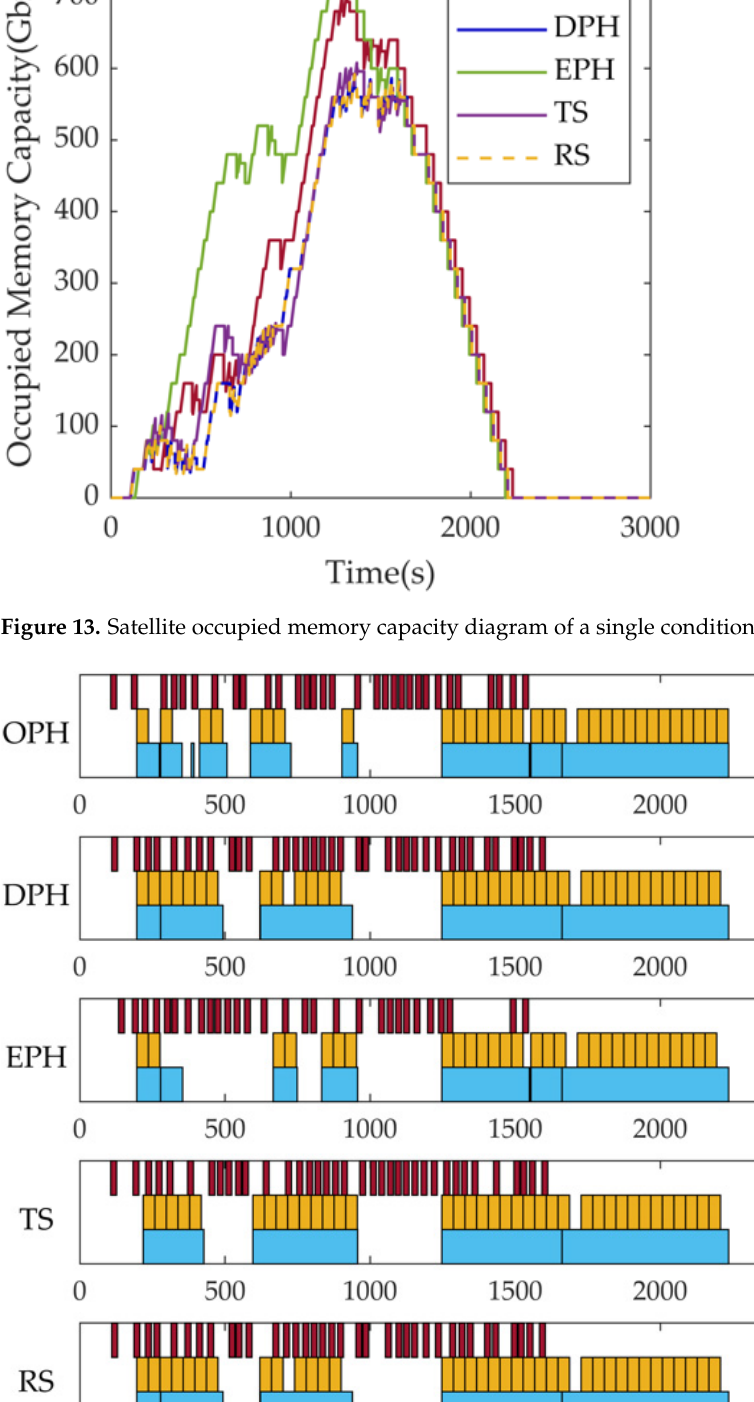
Figure 14. Observation and data transmission time period diagram of a single condition in the sec- ond group. Likewise, Figure 15 shows the target selection and observation path of a condition in the second group. It can be seen that the available memory capacity was sufficient but was deficient in electrical energy during the satellite observation process from Figures 16 and 17. From Figure 18, EPH, TS, and RS chose more targets that could obtain more electrical